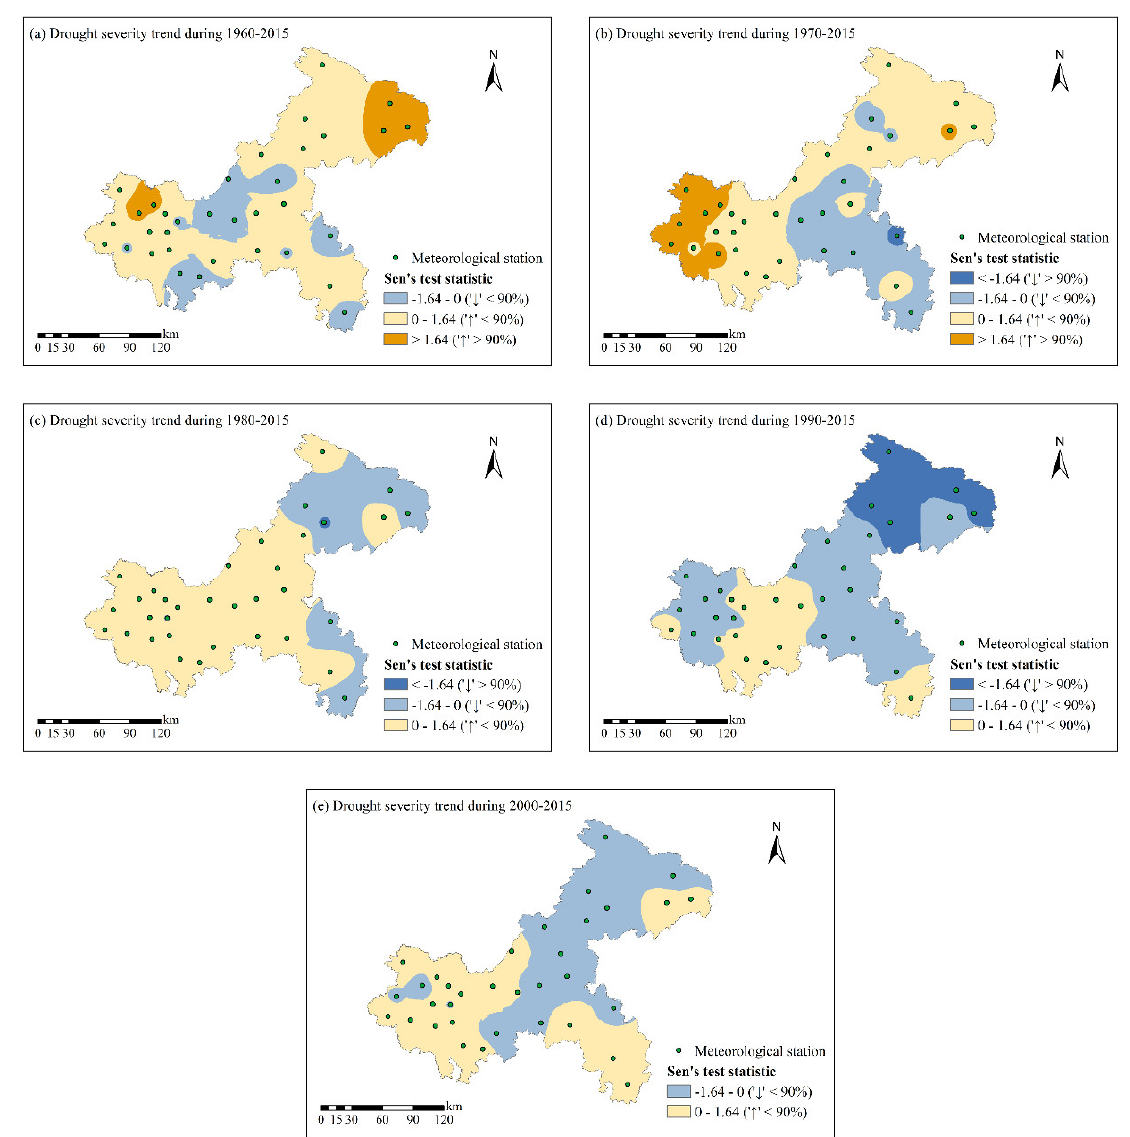
Figure 5. Spatial distribution of trend evolution of annual drought severity for ( a ) 1960–2015, ( b ) 1970–2015, ( c ) 1980–2015,